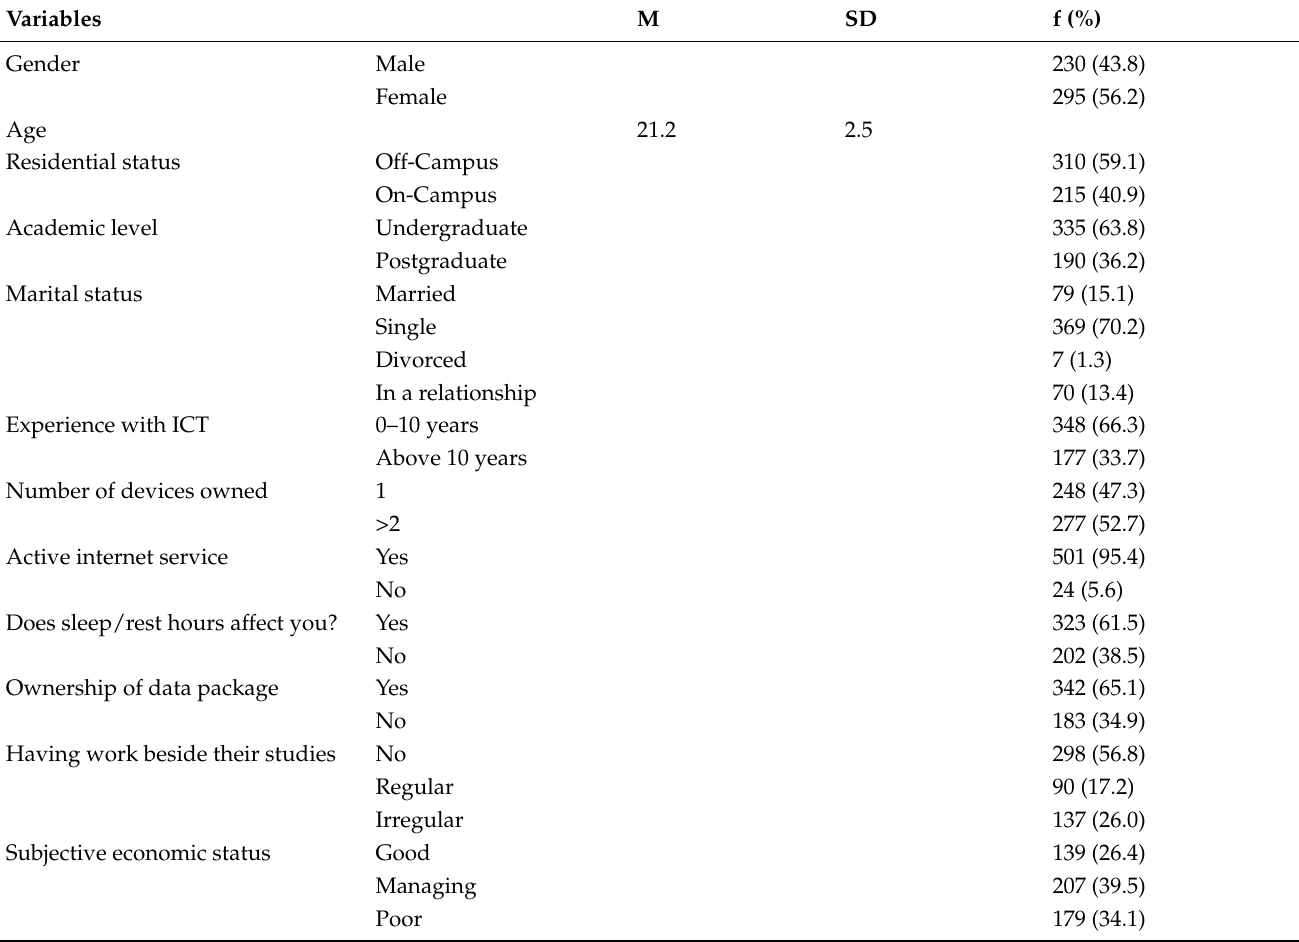
Table 3. Sociodemographic profiles of the participants (n = 525).